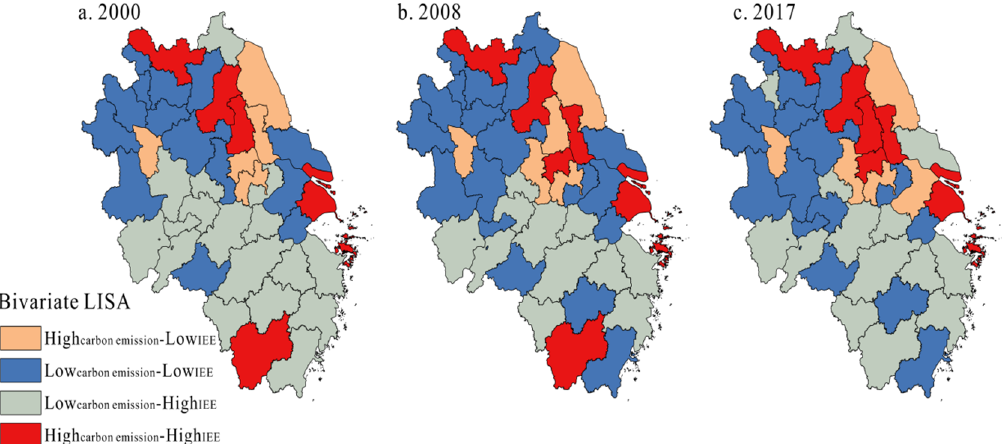
Figure 3. Local spatial association between IEE and carbon emissions in ( a ) 2000, ( b ) 2008 and ( c ) 2017.